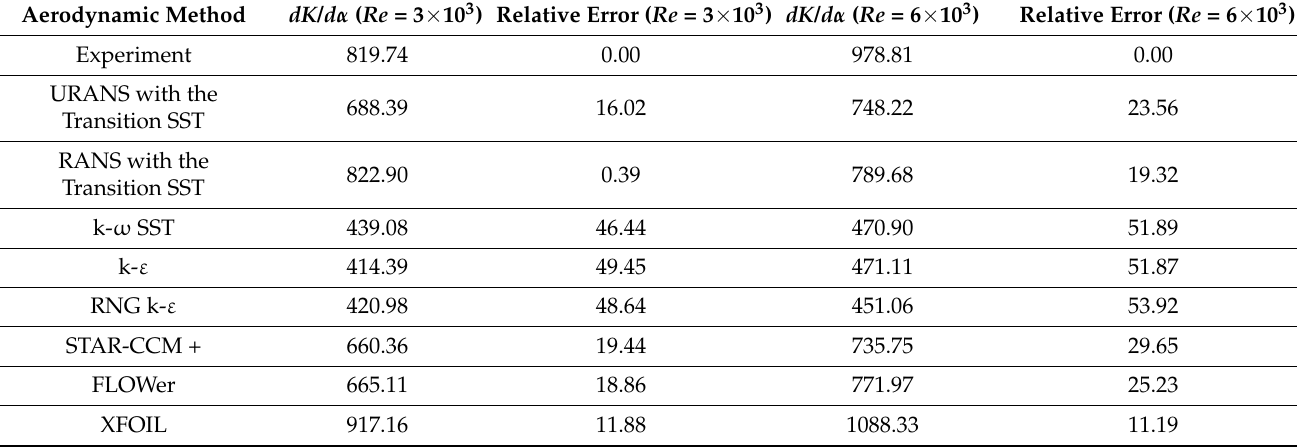
Table 2. The derivative of the lift-to-drag ratio dK / d α for the range of angles of attack from 0 ◦ to 4 ◦ and for different aerodynamic